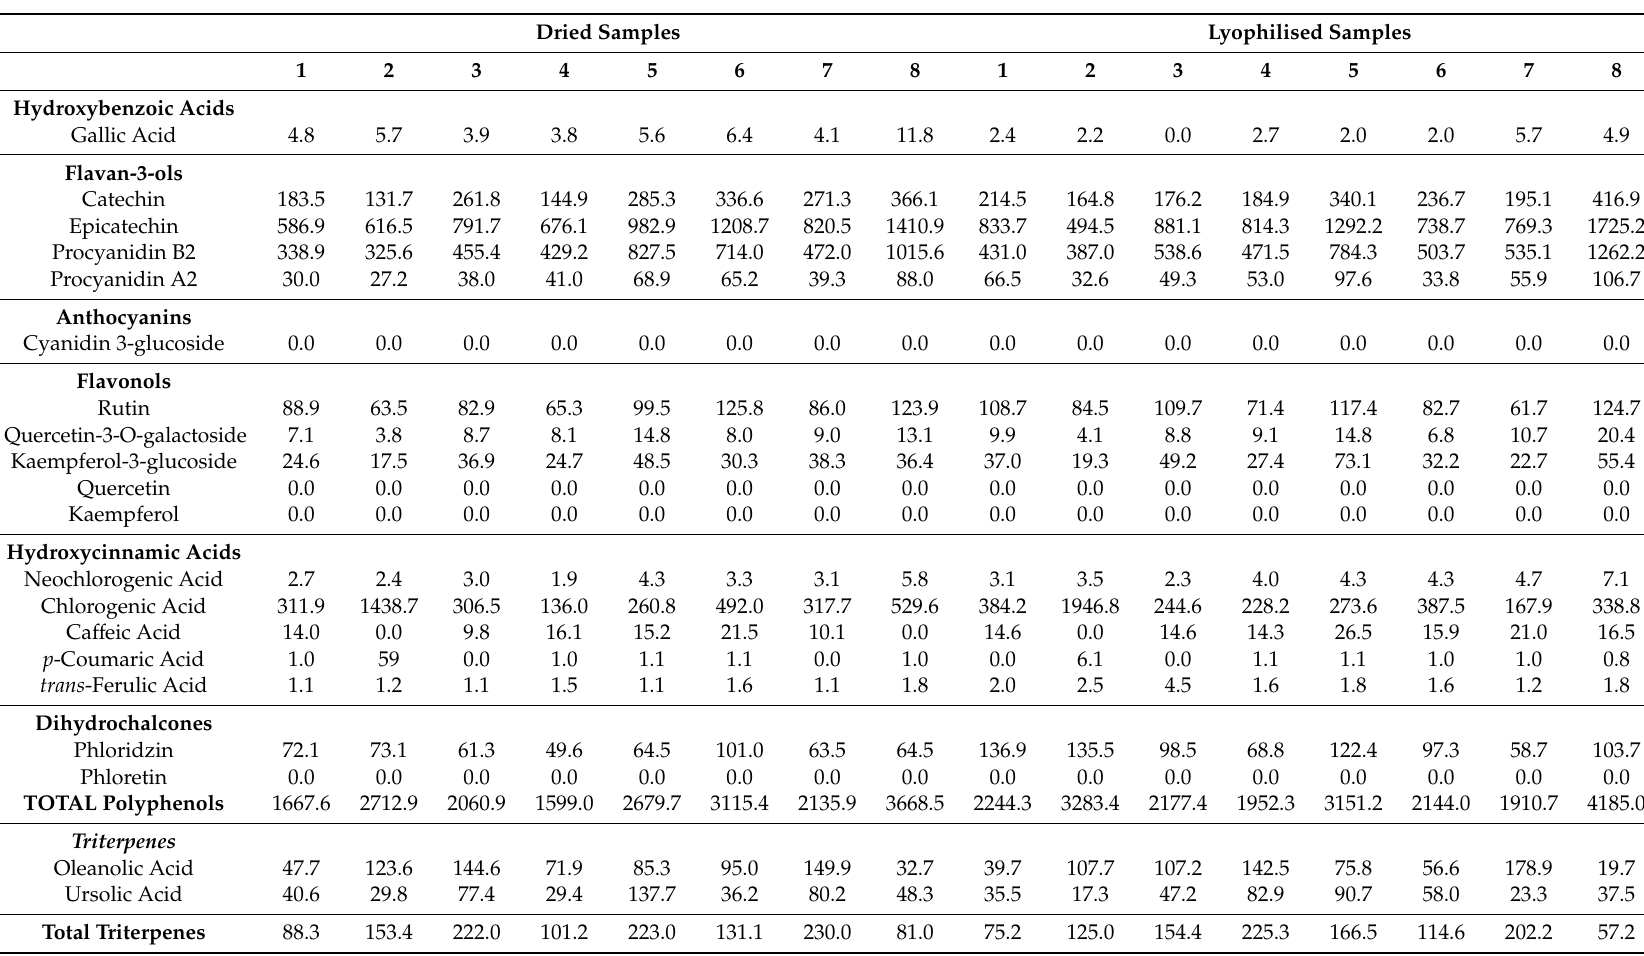
Table 2. Concentrations of phytochemicals, expressed in mg / kg, of the extracts obtained from the dried and lyophilized pulp samples of Mela Rosa dei Monti Sibillini. Dried Samples Lyophilised